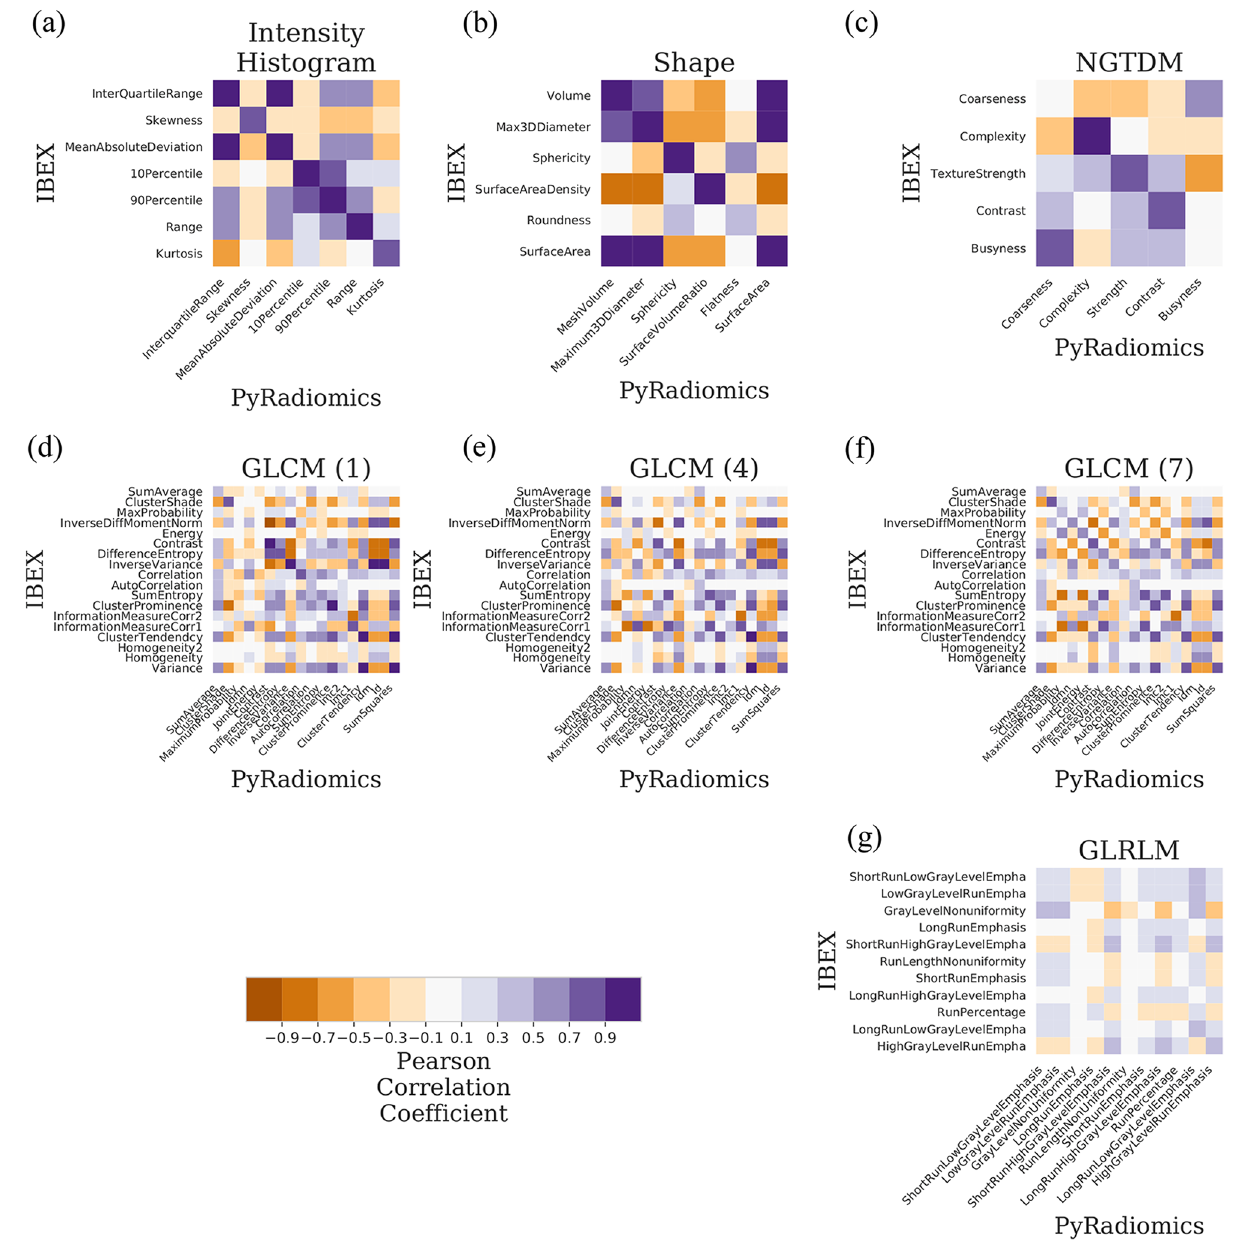
Figure 2. Linear correlation of apparent diffusion coefficient (ADC) radiomics features between IBEX and PyRadiomics software. Correlation matrices are grouped by feature class such as ( a ) intensity histogram ( b ) shape ( c ) NGTDM ( d – f ) GLCM and ( g ) GLRLM with colour representing the Pearson correlation coefficient (r). An ideal correlation matrix would have diagonal elements of highly correlated features (r = 1.0, dark purple) between software packages. A list of shared features between software packages is in Supplementary Tables